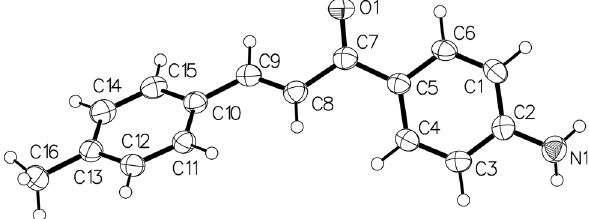
Table  : Data collection and